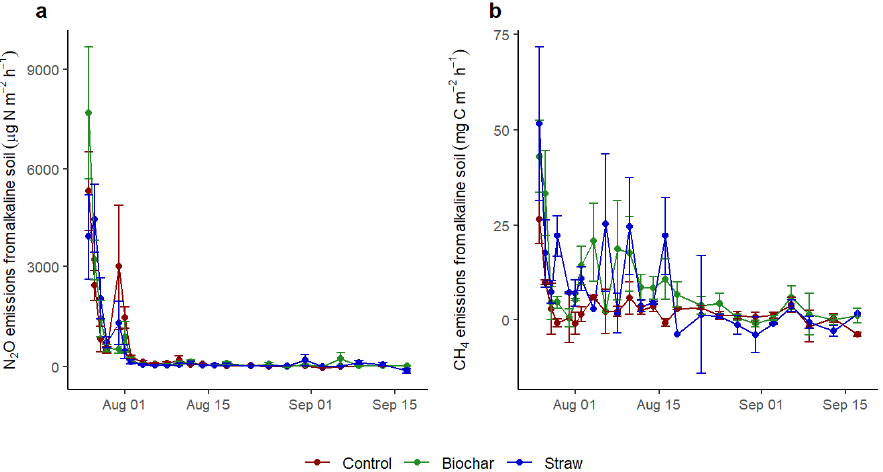
Figure 4. Soil ( a ) N 2 O and ( b ) CH 4 emissions between 20 July 2020 and 16 September 2020 in alkaline soil amended with maize straw (6 t ha − 1 ) and corn biochar (20 t ha − 1 ) in the packed soil column study. The vertical bars denote the standard error of the mean (n = 3).